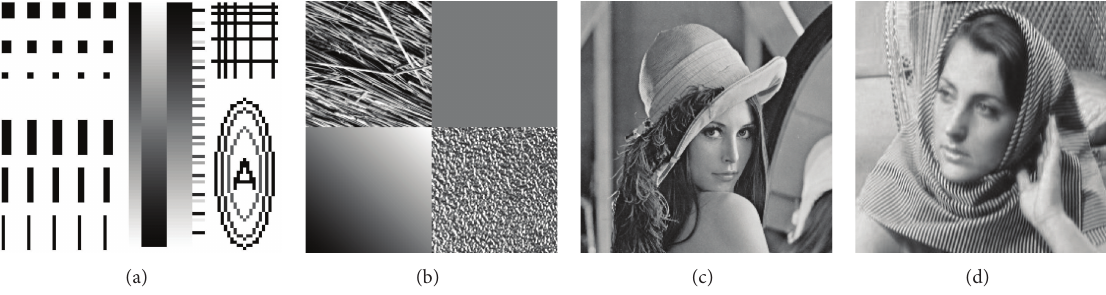
Figure 2: Original images: (a) synthetic image 1 ( 128 × 128 ), (b) synthetic image 2 ( 256 × 256 ), (c) “Lena” ( 256 × 256 ), and (d) “Barbara” ( 256 × 256